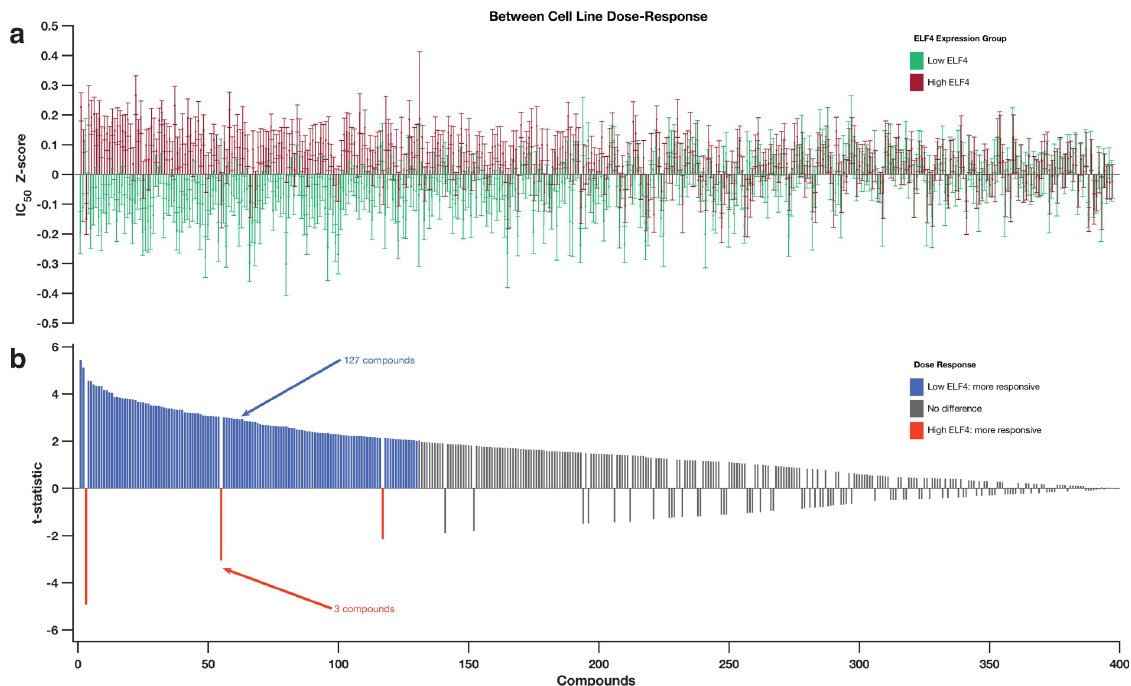
Fig 3. (a) Comparison of the dose-response profiles between the GDSC cancer cell lines that express higher ELF4 and those that express lower ELF4 transcript. The bar graphs show the logarithm IC50 values of the cancer cell lines that correspond to those that express higher ELF4 (red bars) and express lower ELF4 (green bar). (b) bar graph shows the t-value calculated using the Welch test for each of the 397 anti- cancer drugs used to profile the dose-response of the cell lines by the GDSC. The drugs along the columns are matched to the columns in the top plots. The orange bars indicate the drug to which the high-ELF4 cell lines are significantly more responsive; the blue bars indicate drug to which the low-ELF4 cell lines are significantly more responsive. The grey bars show drugs for which we found a non-statistically significant difference in the responsive between the high-ELF4 cell lines and low-ELF4 cell lines. For details refer to S2 File.